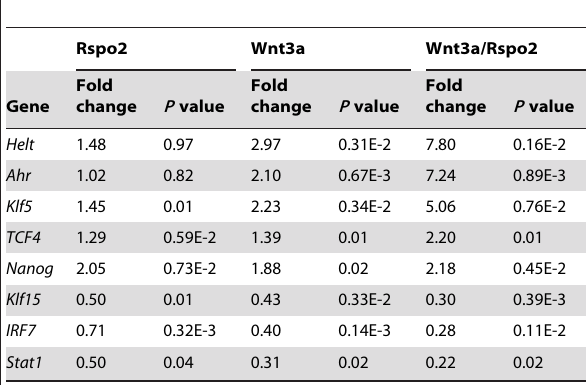
Table 4. Microarray data of transcription factor genes validated by qRT-PCR.